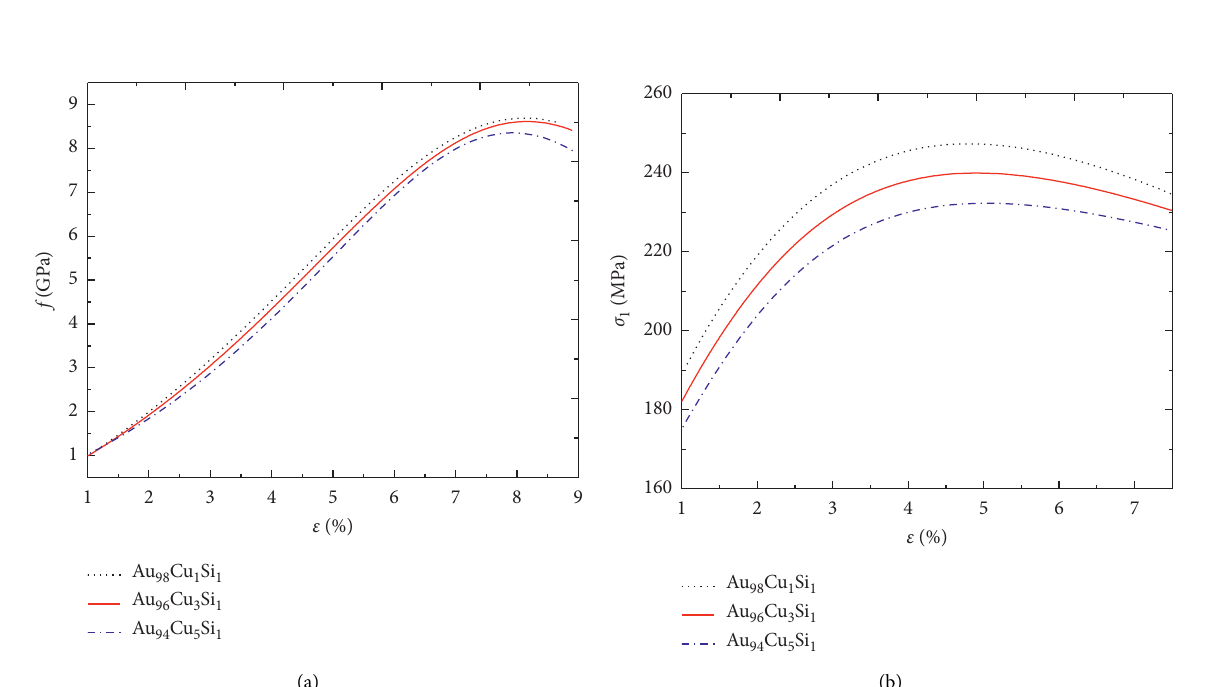
Figure 1: The density of deformation energy f ( ε ) (a) and the real stress σ